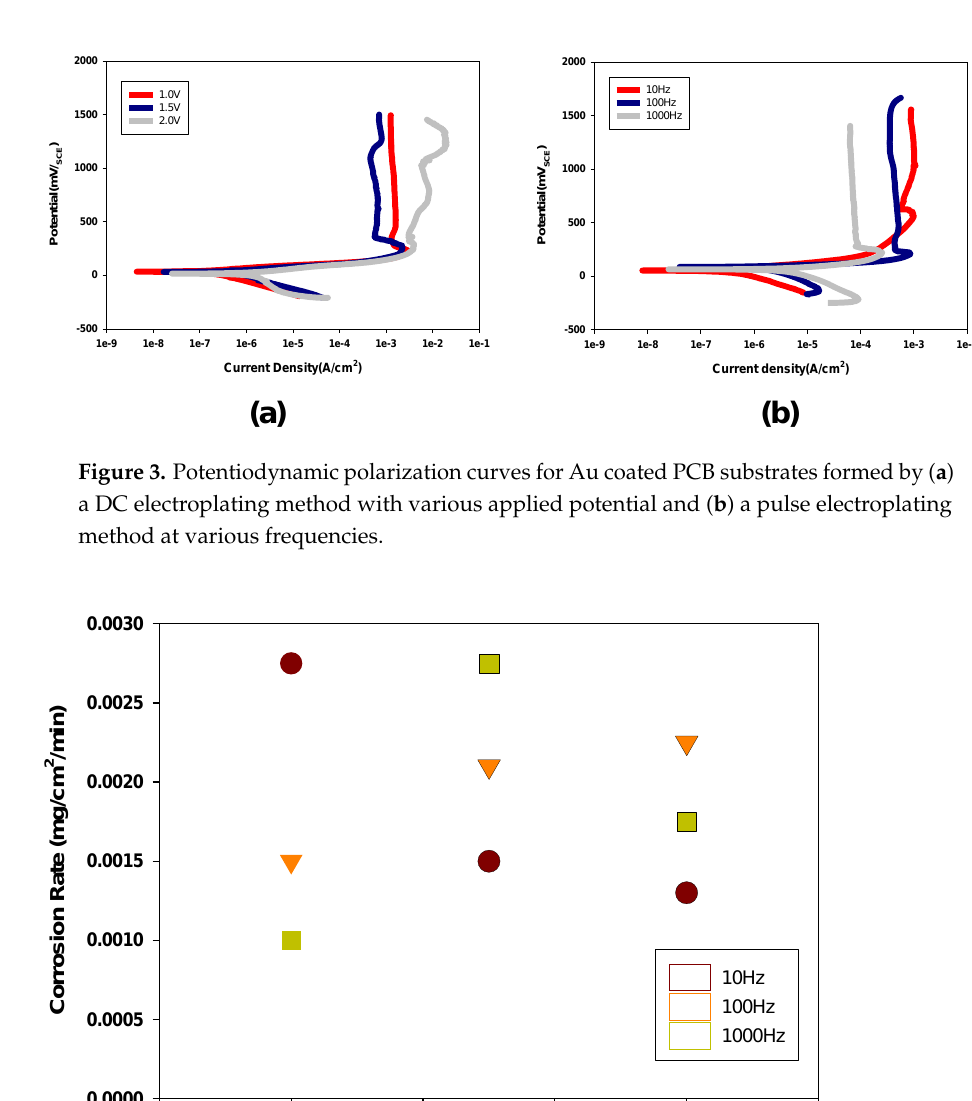
Figure 3. Potentiodynamic polarization curves for Au coated PCB substrates formed by ( a ) a DC electroplating method with various applied potential and ( b ) a pulse electroplating method at var- ious frequencies.